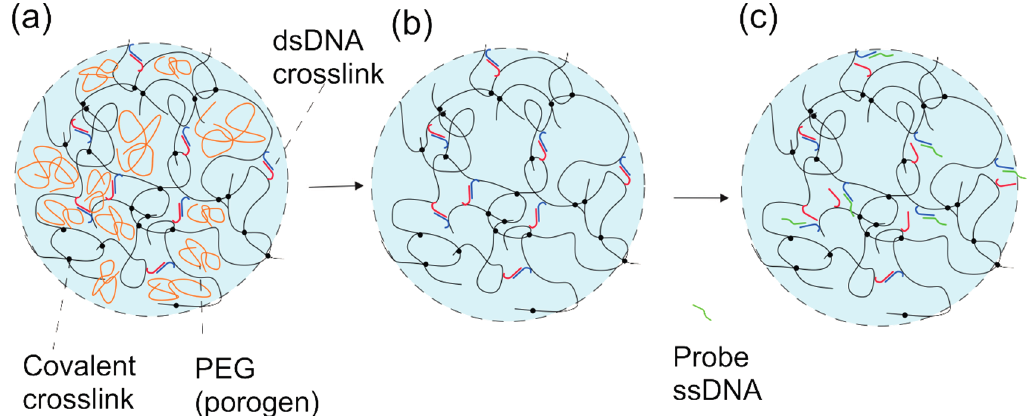
Figure 1. Schematic illustration of the effect of using polyethylene glycol (PEG) as a porogen in the synthesis of DNA hybrid hydrogel and single-stranded DNA competitive displacement of double-stranded, supported crosslinks ( a – c ). Hydrogels are prepared in the presence of polyethylene glycol, subsequently removed by washing in buffer, to yield hydrogels with an altered structure ( a , b ). DNA hybrid hydrogels prepared in the presence of polyethylene glycol are prepared where the physical crosslinks in the network are made up of double-stranded oligonucleotides with partial complementary bp sequences denoted as sensing (blue) and blocking (red). Swelling response is induced by the oligonucleotide complementary displacement reaction in the presence of an oligonucleotide probe (green), destabilizing the junctions ( b , c ), which results in swelling of the hydrogel, determined as the change in the optical length, Δ l opt using an